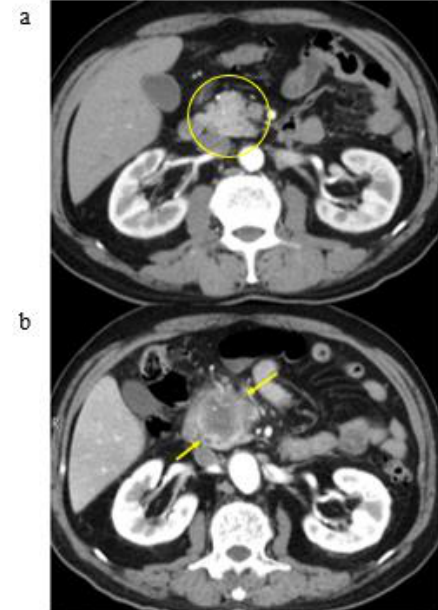
Figure 6. Group C (a representative patient with no abnormality): ( a ) April 2009: pancreatic head looks normal with well enhancement (a yellow circle); ( b ) December 2017: pancreatic head cancer is shown (yellow arrows).